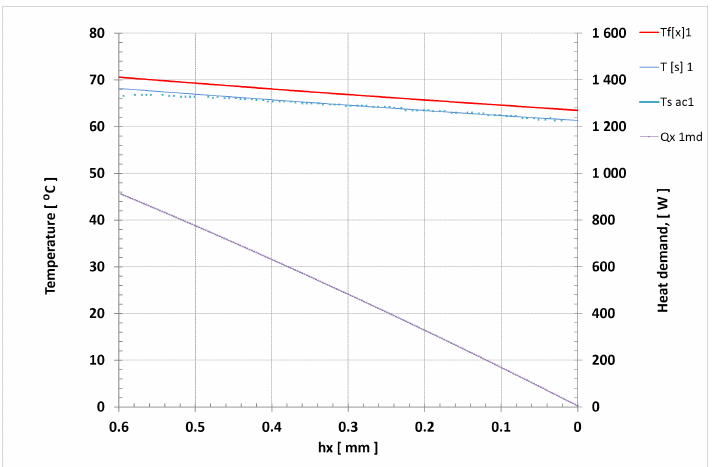
Figure 11. Comparison of measurement and calculations results of water temperature, radiator surface temperature and radiator heat out distribution—measurement 1: t s = 70.0 ◦ C, t r = 63.4 ◦ C, t i = 21.1 ◦ C, m r = 0.0307 kg/s ( m rmax )